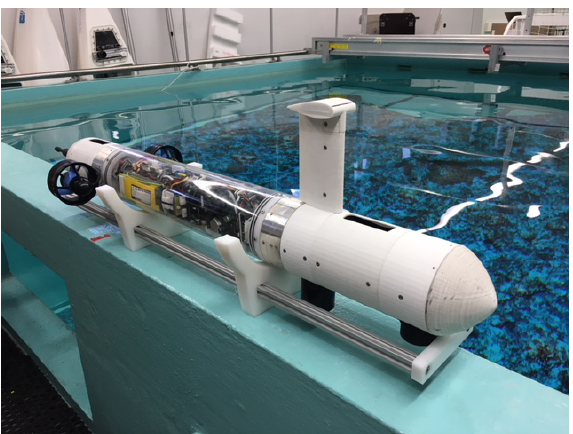
Figure 9. The SHAD AUV and the water tank structure used for testing procedures. The presented testing scenario was chosen due to the associated complexity.